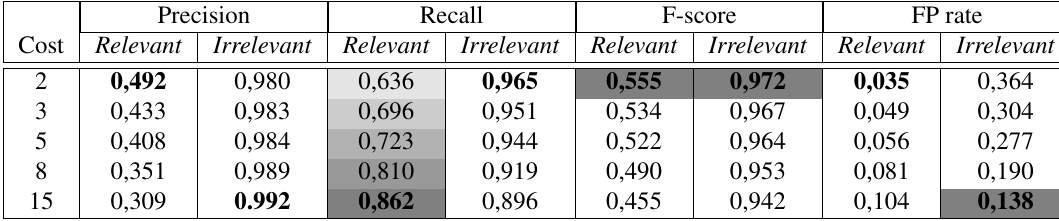
Table 8: Results of a cost-sensitive BN classifier using different cost values for category A. Precision